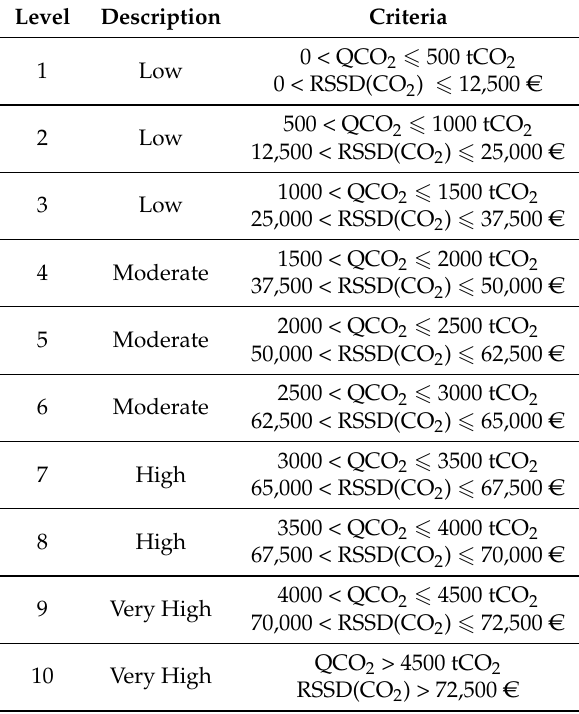
Table 5. Evaluation criteria to assess environmental impact.